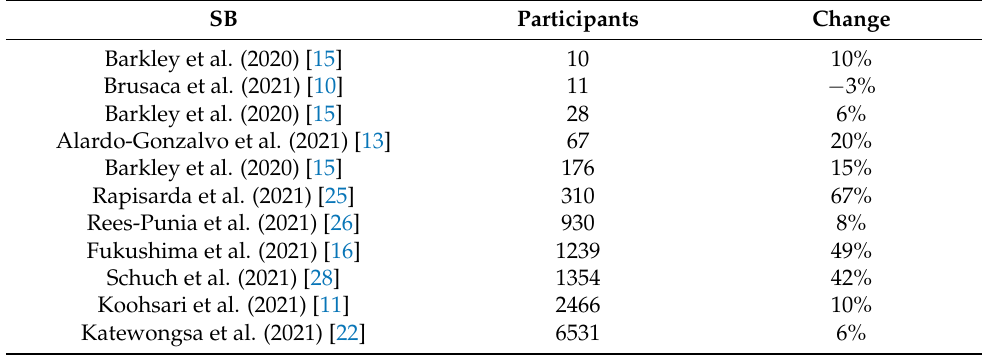
Table 3. Change in sedentary